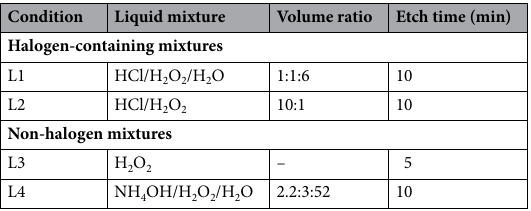
Table 2. A list of four experimental conditions (L1, L2, L3, and L4) of liquid mixtures that were mixed at room temperature for wet etching of TiAlC